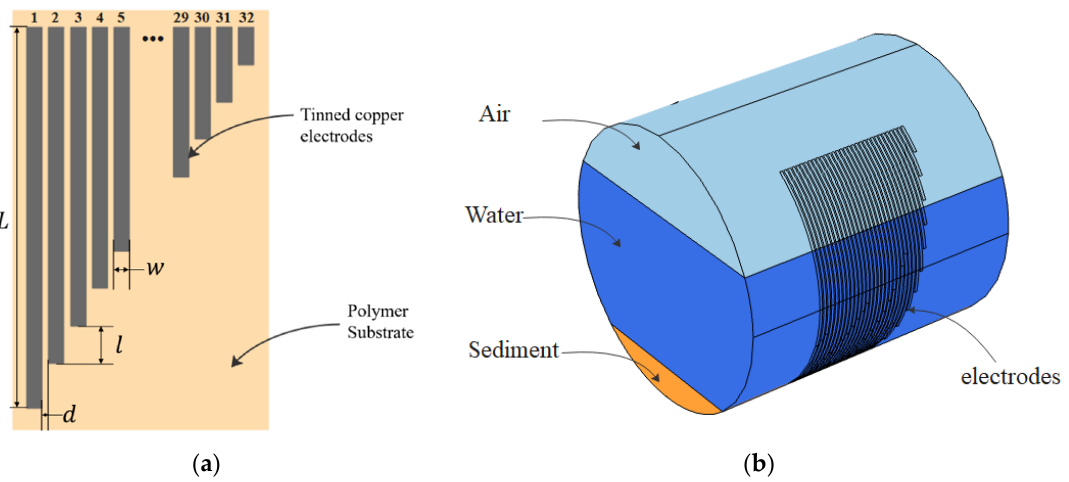
Figure 1. ( a ) Schematic drawing of the conductive sensor; ( b ) 3D view of the arrangement of the sensor and media in a circular pipe.